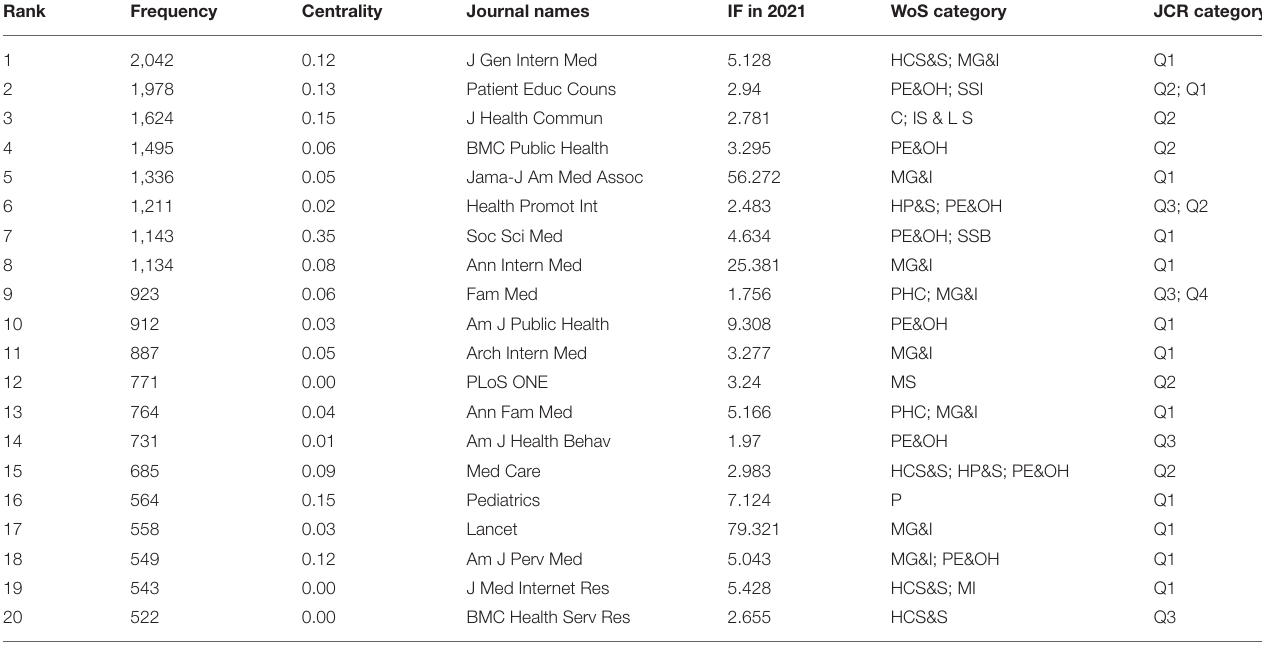
TABLE 1 | The top 20 journal in the field of health literacy research. Rank